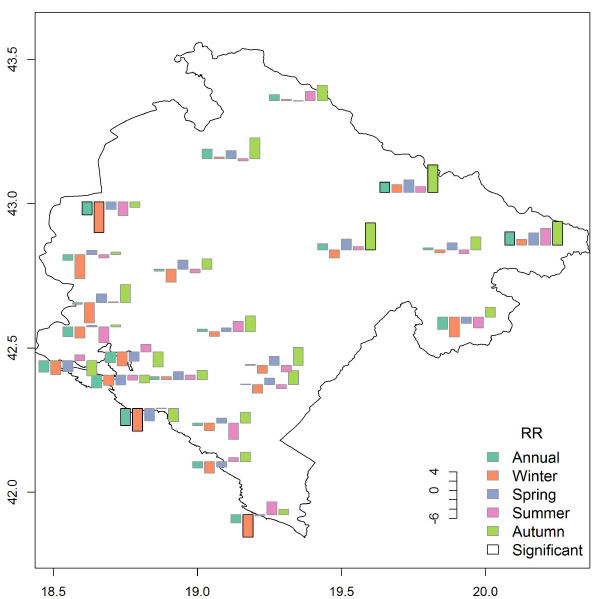
Figure 3. Decadal trends in the annual and seasonal mean precipi- tation (RR) in %dec − 1 .